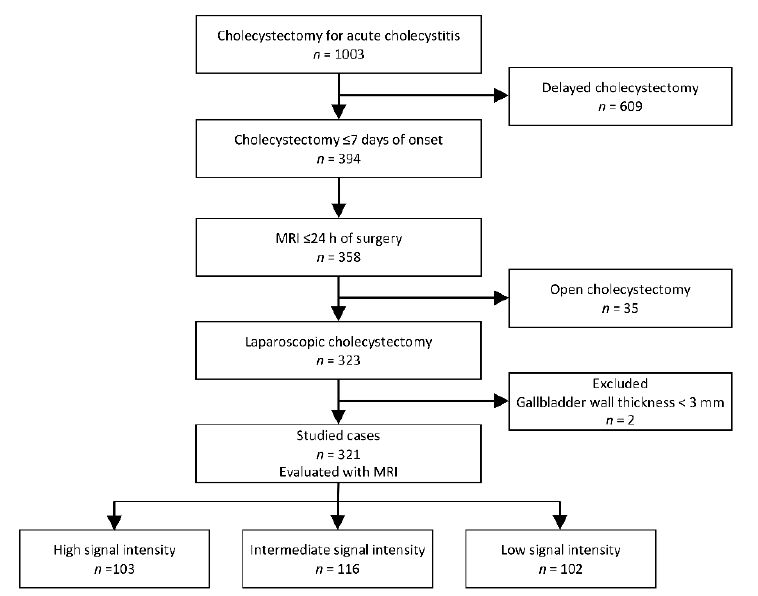
Figure 2. Study population diagram.